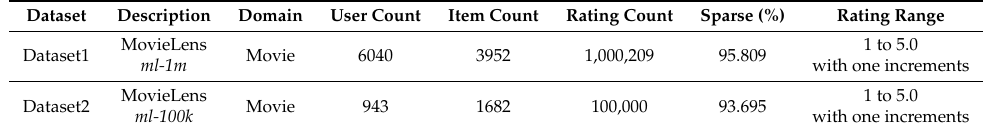
Table 13. Descriptons of the collected